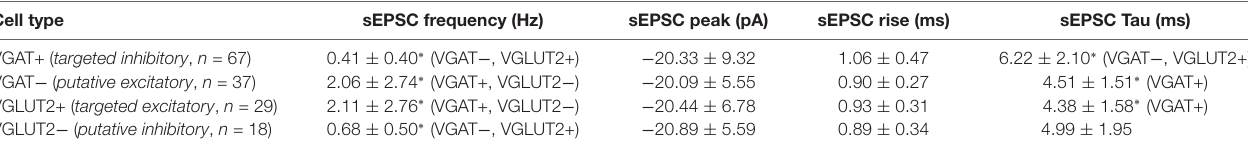
TABLE 4 | Excitatory synaptic input